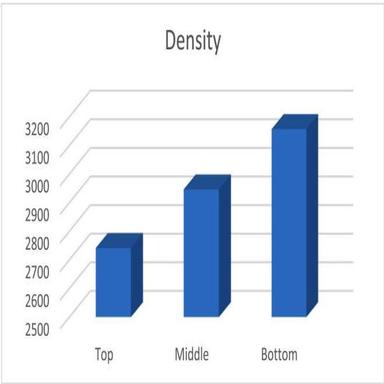
Density variation in the Core Catcher model after stratification.